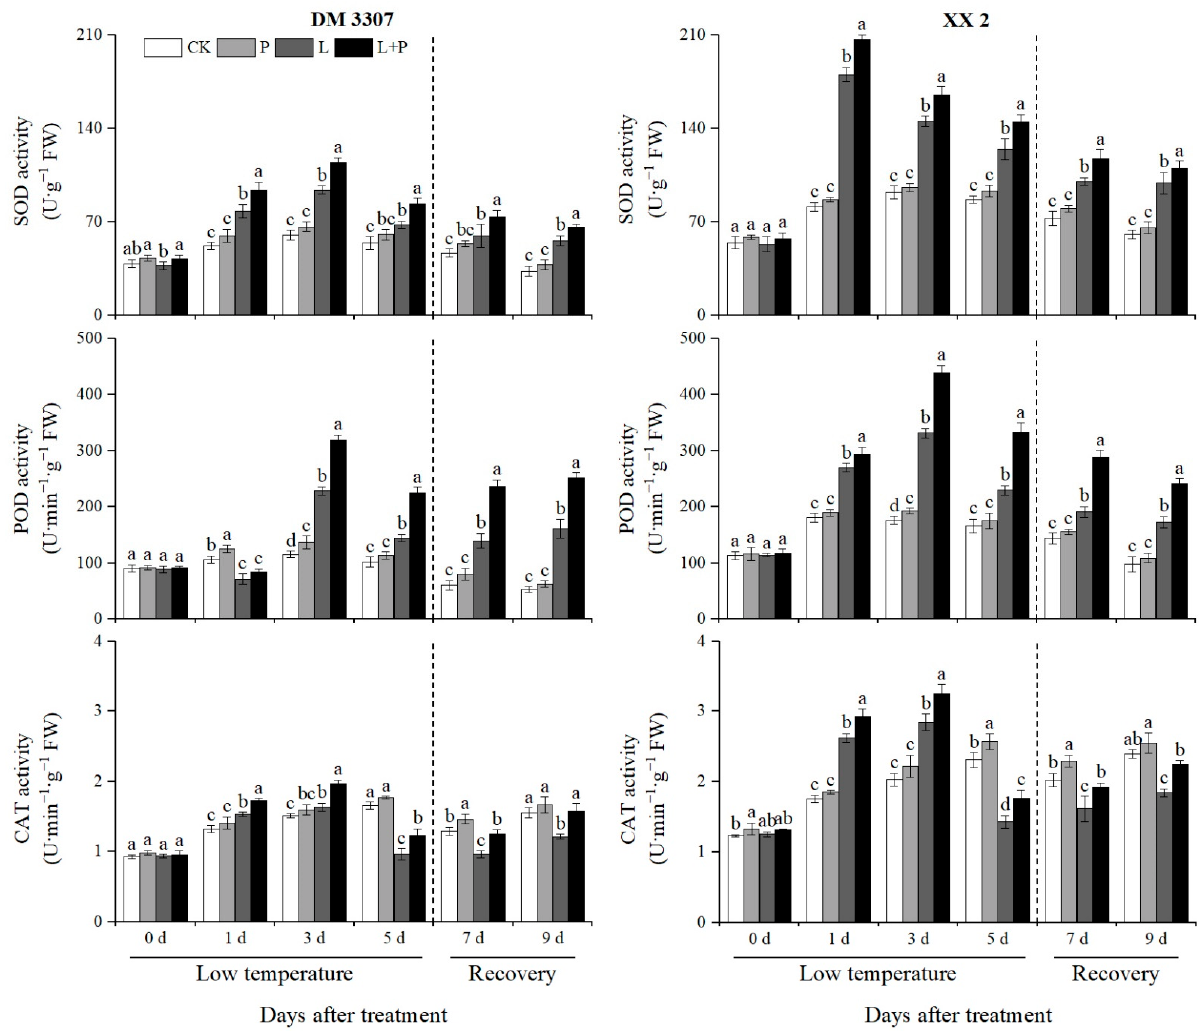
Figure 3. Effect of exogenous proline on the activities of SOD, POD and CAT in embryos of maize under low-temperature stress. Notes: Data are expressed as mean ± standard deviation. Different letters within the same column indicate significant differences at the 5% level. CK: control group; P: proline treatment; L: low-temperature stress treatment; L + P: low-temperature stress + proline combined treatment. Different small letters represent significant differences between treatments ( p < 0.05).